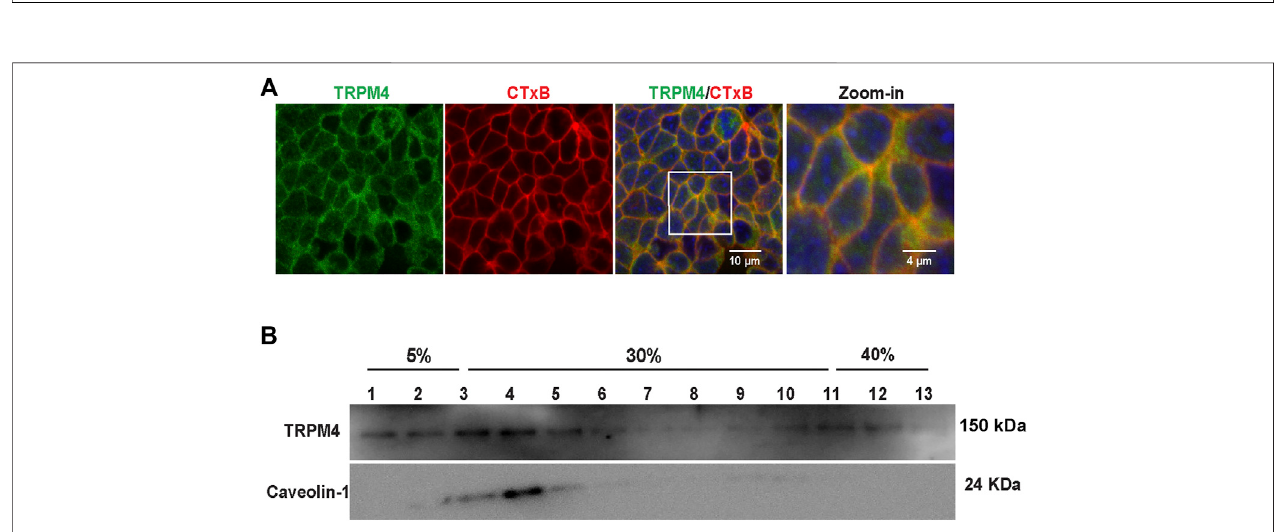
FIGURE 6 | TRPM4 channels are mainly located in lipid rafts. (A) Representative confocal microscopy images indicate that majority of TRPM4 (green) was co- localized with cholera toxin B (red) in the apical membrane; white rectangular box indicate zoomed-in areas shown in the Zoom-in panels. Data represent fi ve individual experiments showing consistent results (B) Majority of TRPM4 was detected in low-density regions in sucrose gradient experiments; Caveolin-1 was used as a control protein that is known to be located in lipid rafts. Data represent three individual experiments showing consistent results.